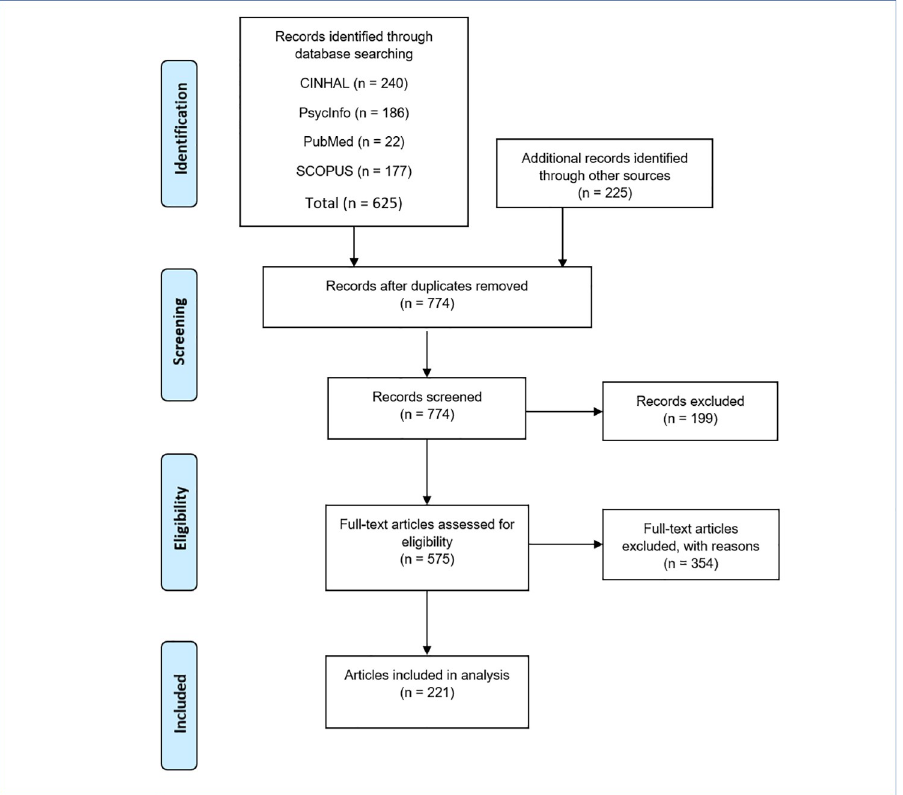
Fig 1. Flowchart of scoping review: Characterisation of adult